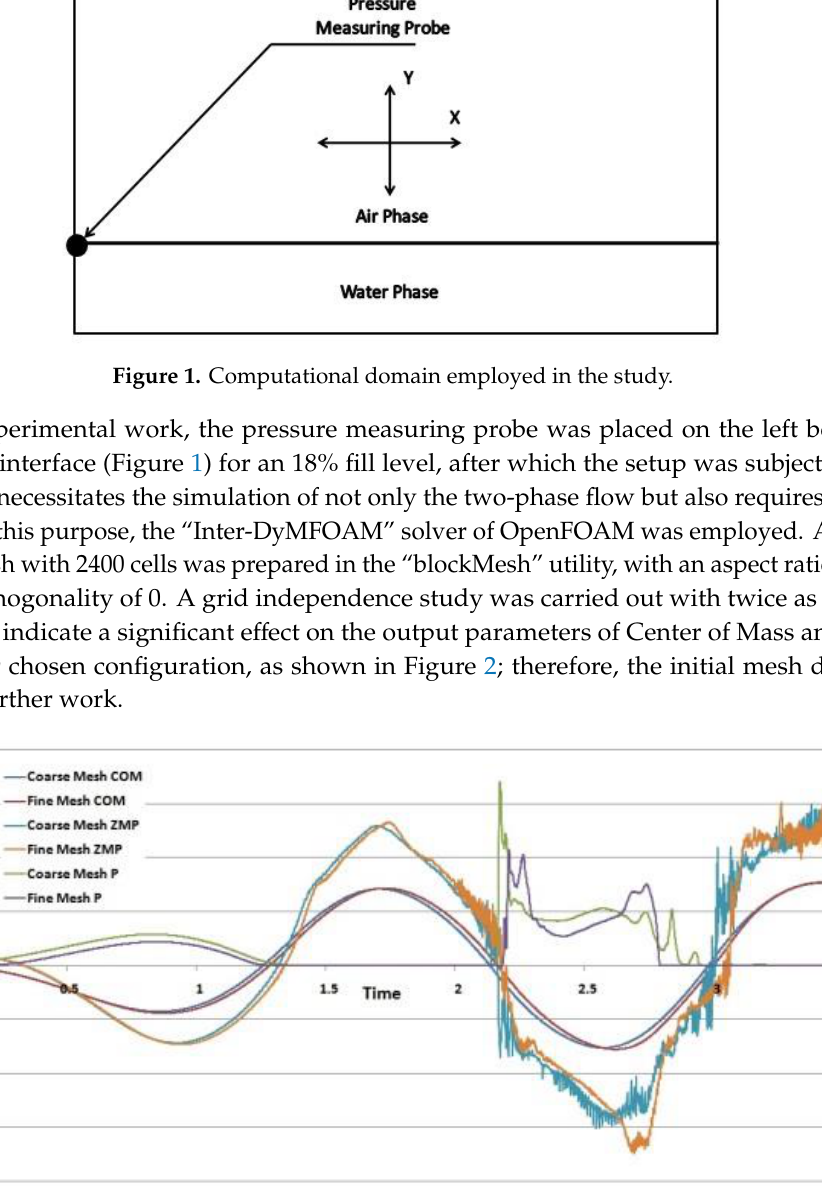
Figure 2. Grid independence study comparing center of mass (COM), zero moment point (ZMP) and pressure P, for coarse and fine meshes.